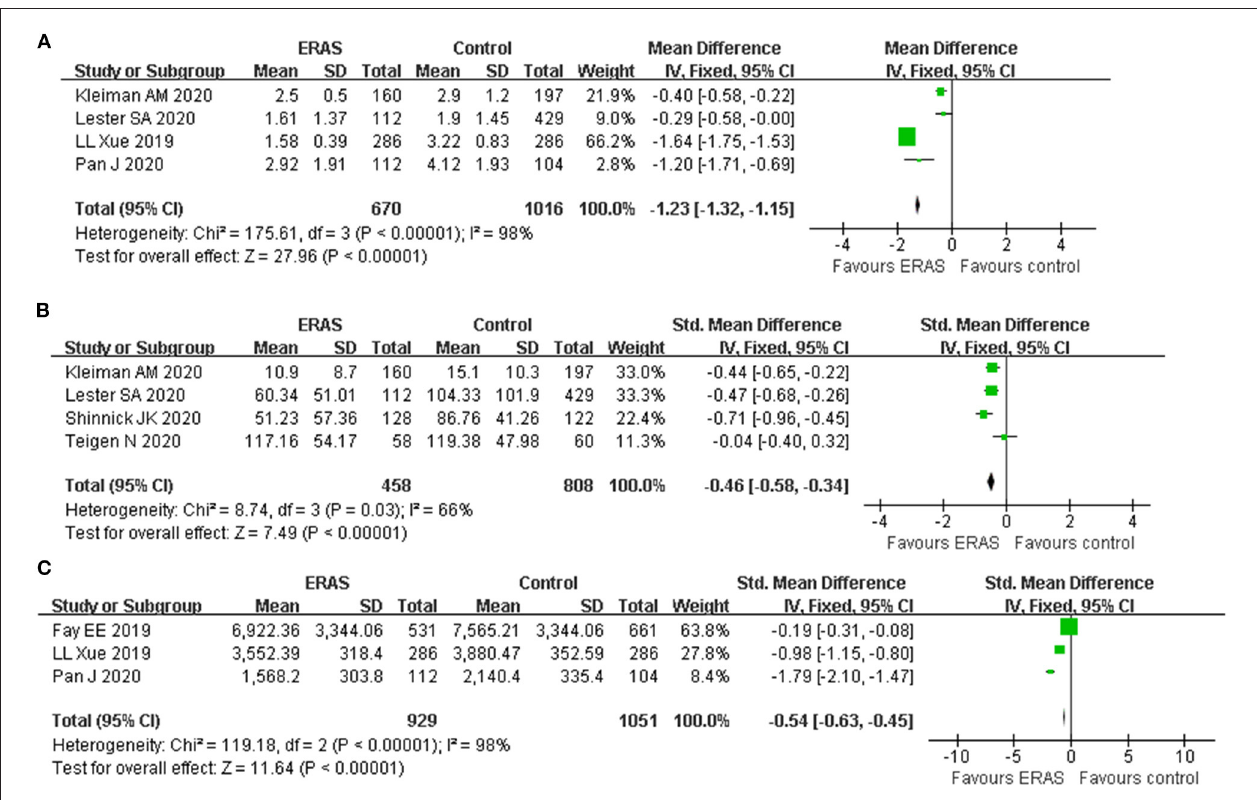
FIGURE 5 | Forest plots with (A) postoperative pain score; (B) opioid use; and (C) cost of